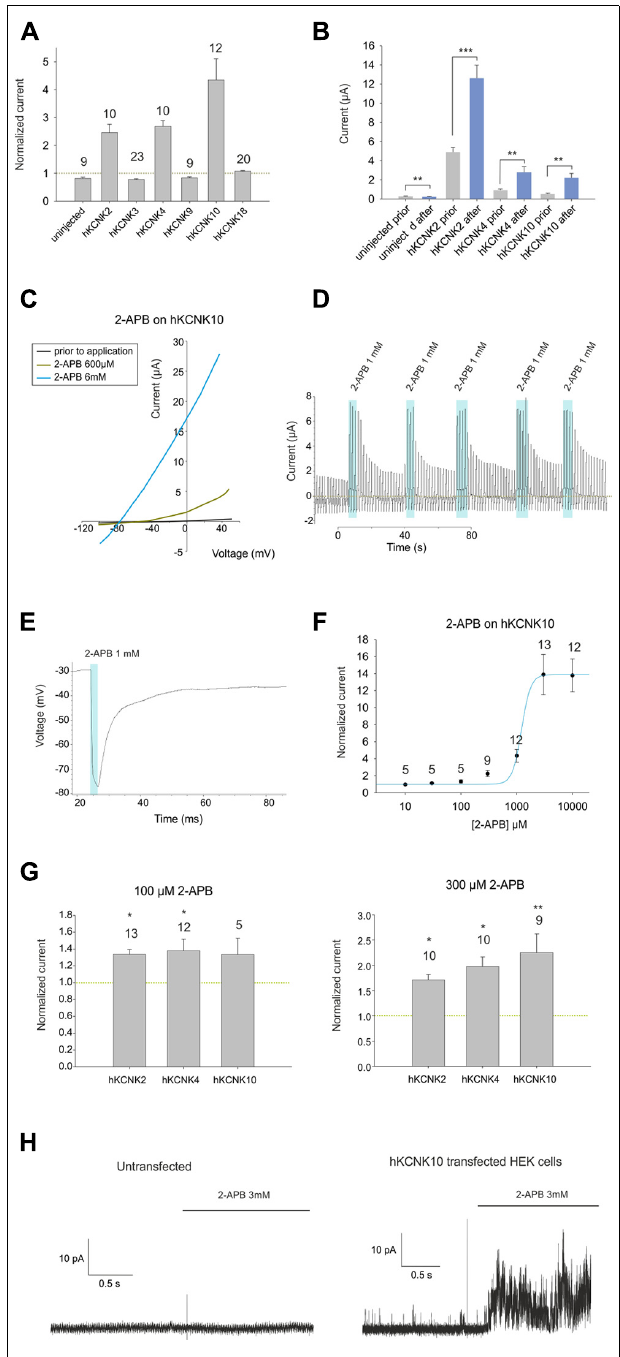
FIGURE 1 | (A) Effect of 1 mM 2-APB on (from left to right) uninjected Xenopus oocytes and oocytes injected with cRNA coding for hKCNK2, hKCNK3, hKNCK4, hKCNK9, hKCNK10, and hKCNK18. For each group, the current registered at the final 50 ms of the + 50 mV constant (see experimental procedures for a description of the ramp protocol used) was normalized to the current registered prior to the application of 2-APB (dotted line). All data are expressed as means ± SEM. Number of cells in each experiment is indicated above the bars. (B) Absolute currents registered in uninjected Xenopus oocytes and oocytes injected with cRNA coding for hKCNK2, hKCNK4, and hKNCK10, before and after